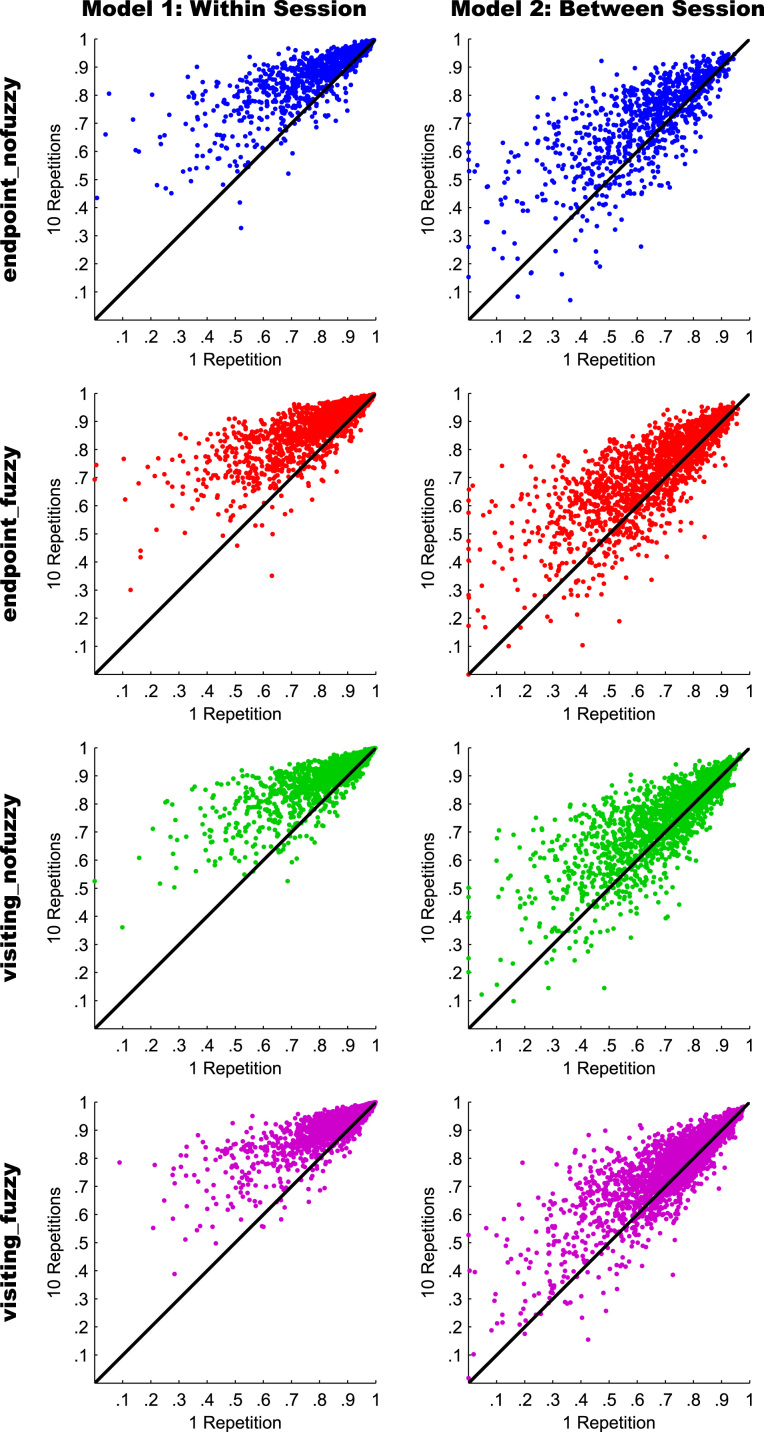
Scatterplots of connection-specific ICC(2,1) values for Models 1 (within session reproducibility; left column) and 2 (between-session reproducibility; right column). In each column and for each streamline selection variant, the ICC(2,1) value for a given connection derived from 1 reconstruction repetition (x-axis) is plotted against the ICC(2,1) value for the same connection derived from 10 reconstruction repetitions (y-axis). Thus, connections with a higher ICC(2,1) value for 10 repetitions are above the diagonal, and connections with a higher ICC(2,1) value for 1 repetition are below the diagonal. For visualization purposes, negative ICC(2,1) values were set to zero (0.08% of values).